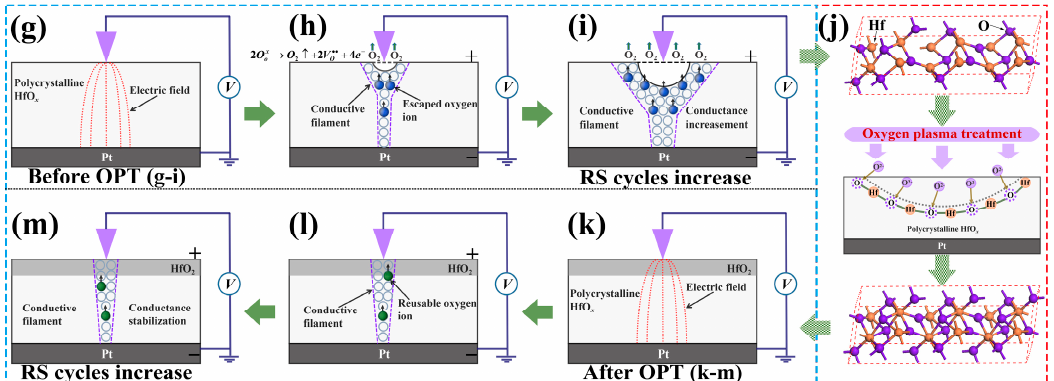
Figure 7. Schematic diagrams for the mechanism of oxygen ions migration in Pt/HfO x /Pt devices, ( a – c ) before OPT and ( d – f ) after OPT. Schematic diagrams for the variation of CFs induced by the structural deformations in the HfO x nanofilm, ( g – i ) before OPT and ( k – m ) after OPT. Particularly, ( j ) gives a schematic physical process of OPT on the HfO x nanofilm.